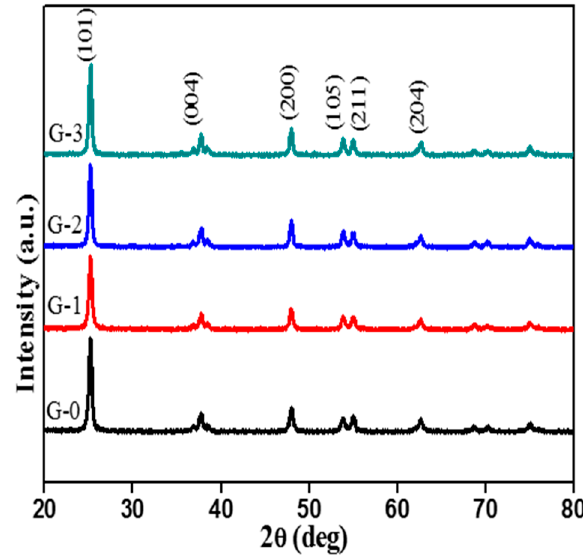
Figure1. XRD Patterns of pure TiO 2 (G-0) and Cu-doped TiO 2 (G-1, G-2,and G-3). Figure 1. XRD Patterns of pure TiO 2 (G-0) and Cu-doped TiO 2 (G-1, G-2, and